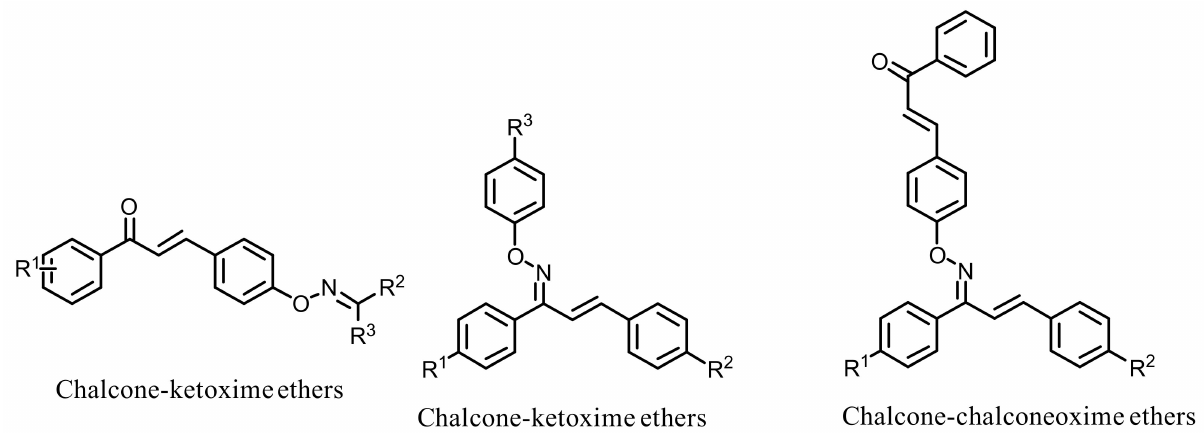
Figure 47. Chemical structures of chalcone oxime ether